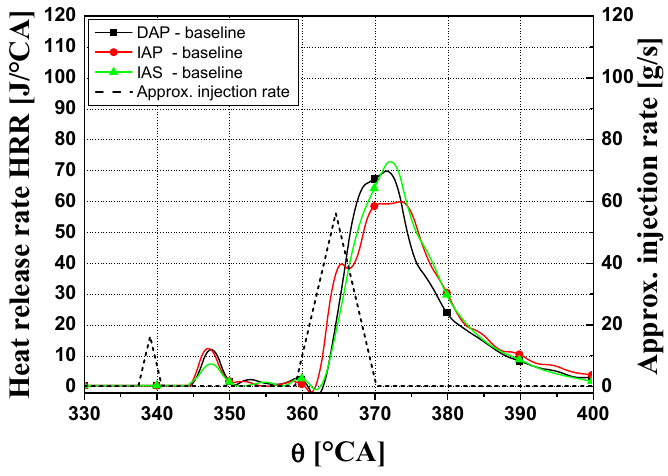
Figure 11. HRR traces of the reference calibrations, at 2500 × 8, for the three injector typologies under